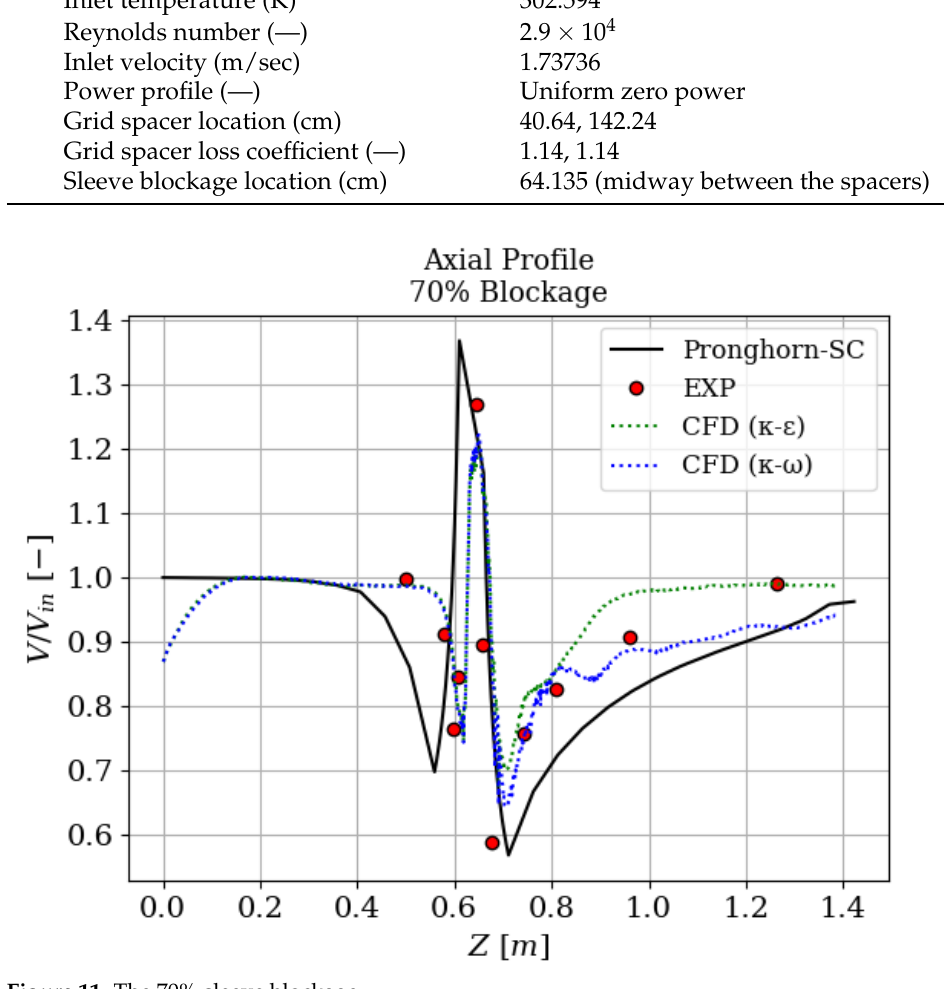
Figure 11. The 70% sleeve